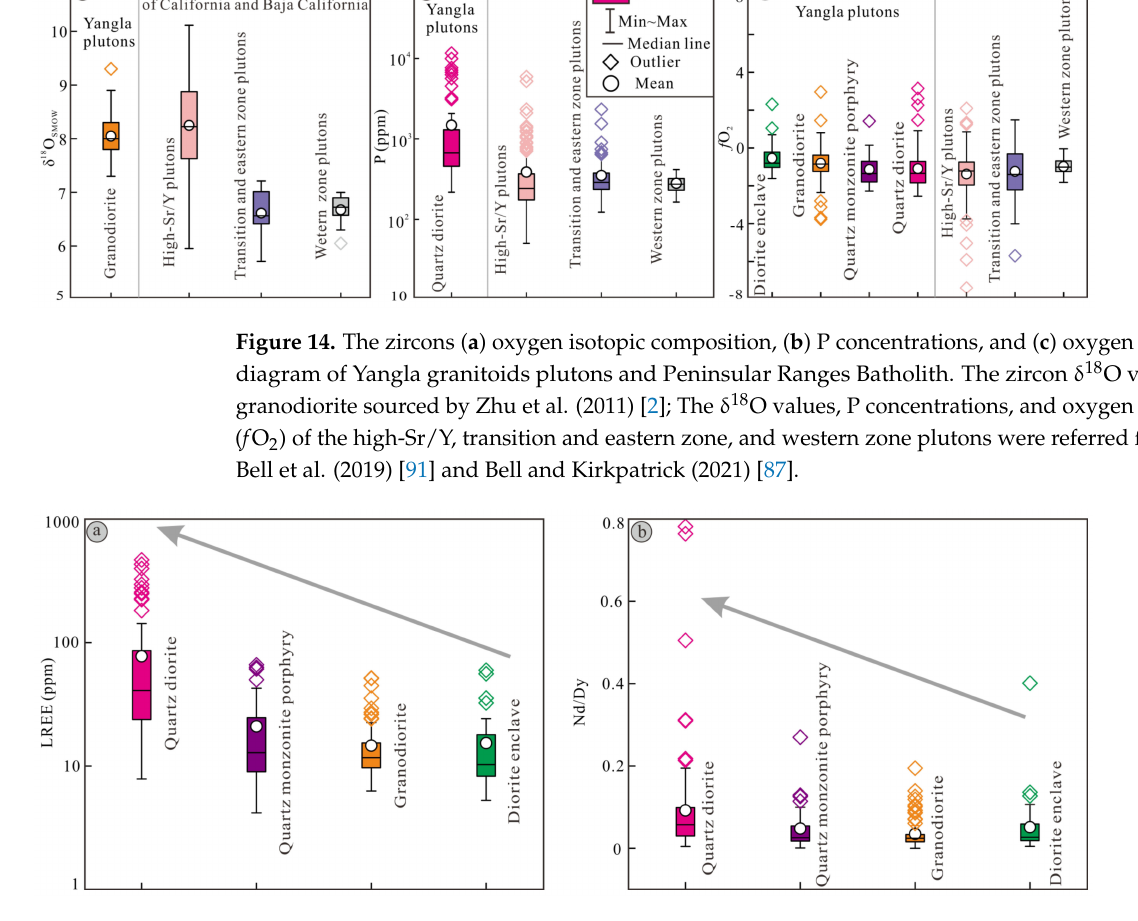
Figure 15. The zircons ( a ) light rare earth element and ( b ) Nd/Dy ratios variation diagram of Yangla granitoids plutons. The data on quartz monzonite porphyry, granodiorite, and diorite enclave was sourced from Meng et al. (2016)